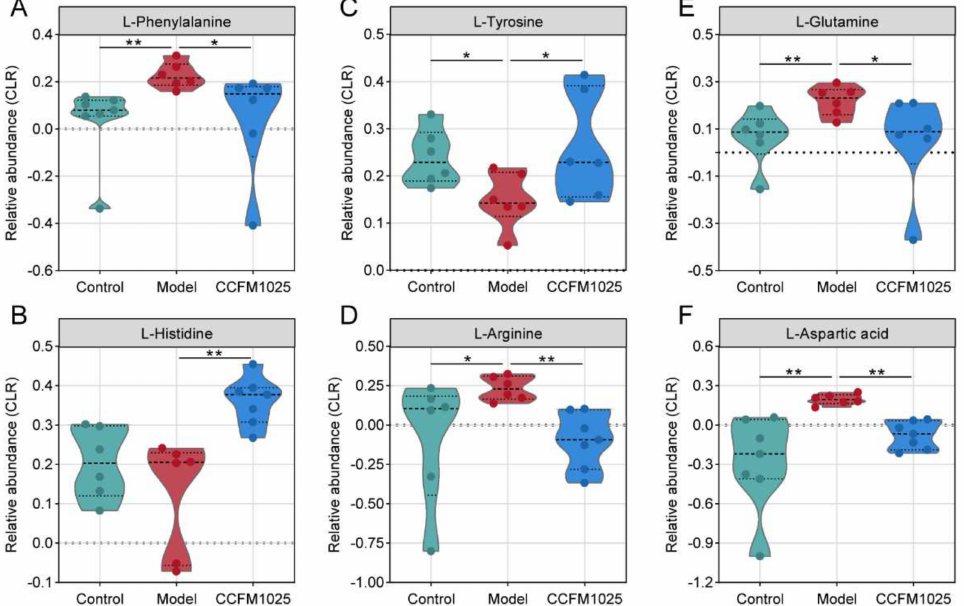
Figure 7. Violin plots representing the significantly altered metabolites after B. breve CCFM1025 treat- ment. Black horizontal lines in violin plots depict the medians. The y axis shows CLR-transformed metabolite concentrations. Mann–Whitney U -test (two-sided) post hoc tests, * p < 0.05; ** p <